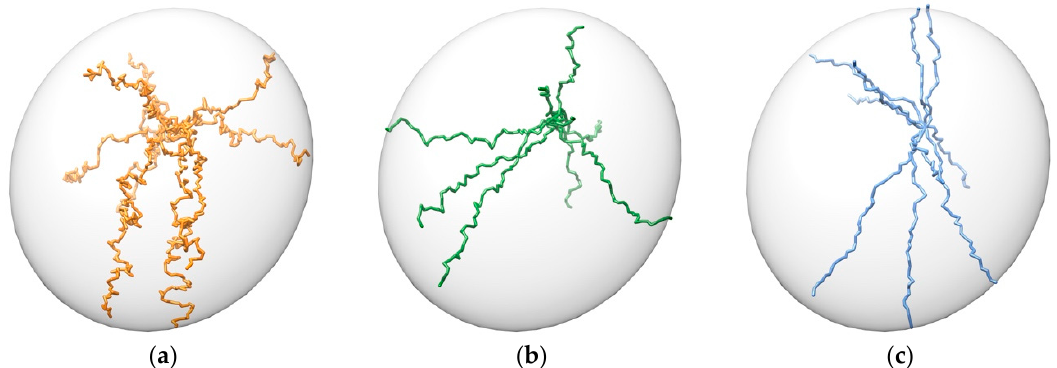
Figure 9. Different shapes of pathways. Maximum distance between points is set to 1 Å in all cases. Minimum increment is set to: ( a ) − 0.4 Å; ( b ) 0.0 Å; ( c ) 0.8 Å. 10 random trajectories from a point inside the ellipsoid towards its exterior are shown for each case.